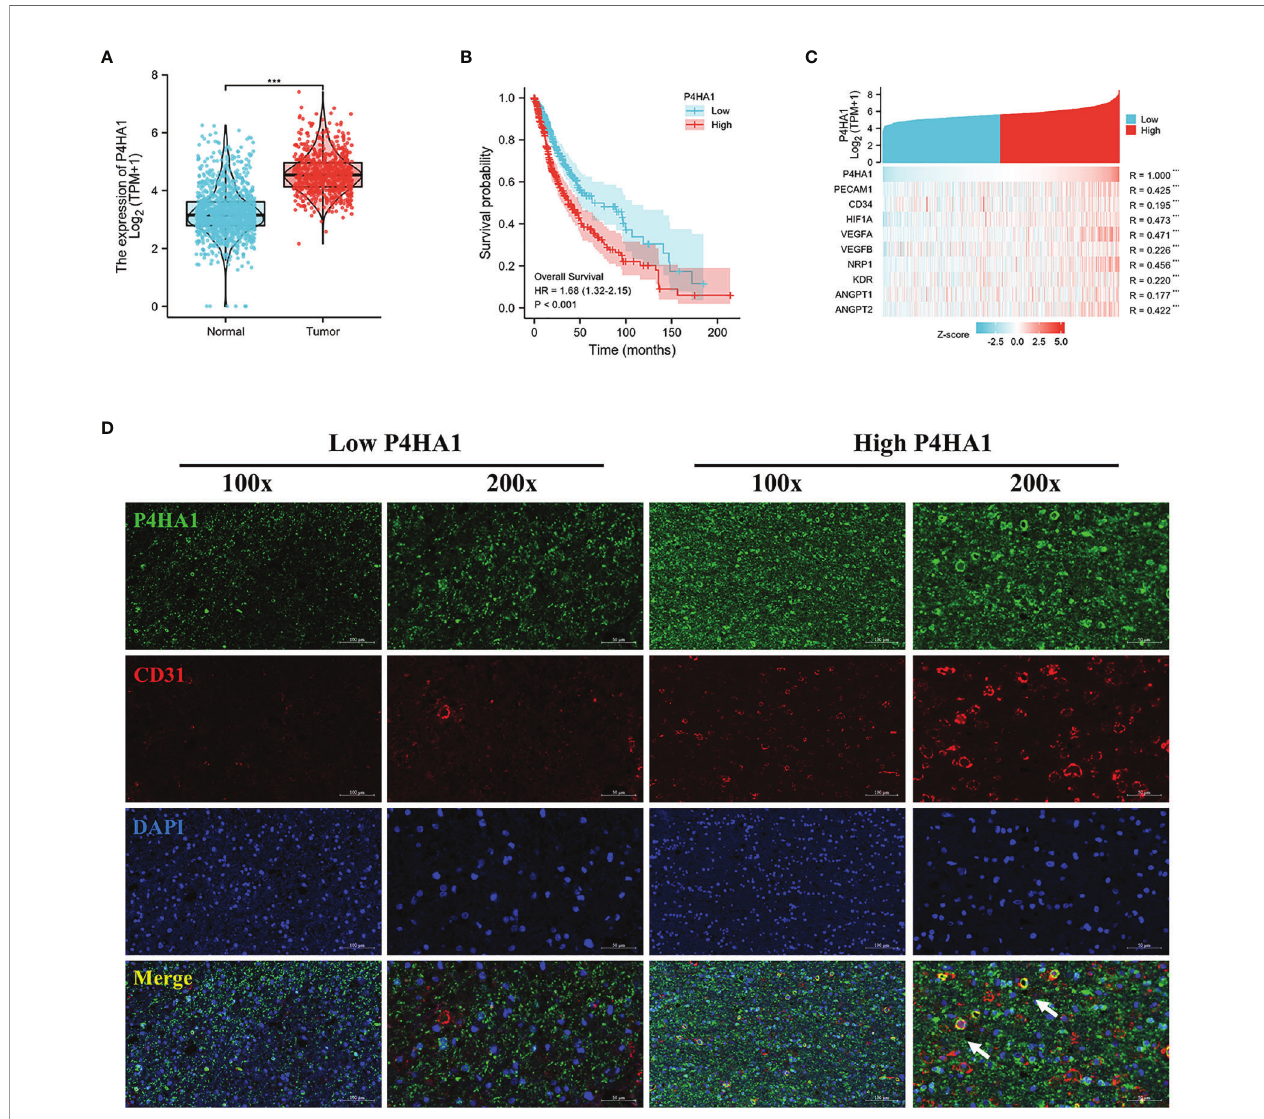
FIGURE 1 | Dysregulation of P4HA1 in glioma and its correlation with the number of blood vessels. (A) Differential gene analysis of data from the TCGA and GTEx databases showed that P4HA1 expression was signi fi cantly higher in glioma tissues than in normal brain tissues. ***P < 0.001. (B) Overall survival analysis of patients with glioma from the TCGA indicated that patients with the high expression level of P4HA1 had a poor prognosis compared with those with the low expression level of P4HA1. (C) Spearman correlation analysis obtained the co-expression heat maps of P4HA1 expression and angiogenesis-related genes based on TCGA database. ***P < 0.001. (D) Immuno fl uorescent analysis of P4HA1 (green) and CD31 (red) showed that the expression of P4HA1 in clinical samples was correlated with the number of glioma blood vessels. The white arrow represents endothelial cells co-located with P4HA1 and CD31. 100X means that the magni fi cation is 100 times(scale bar=100um), and 200X means 200X magni fi cation(scale